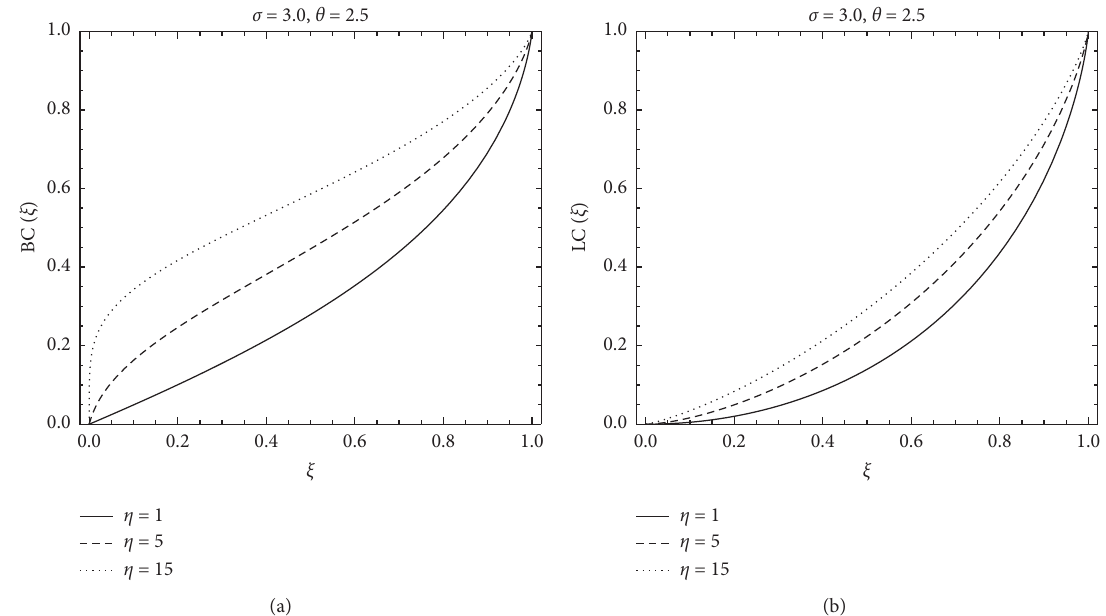
Figure 5: (a) The Bonferroni and (b) Lorenz curves of the